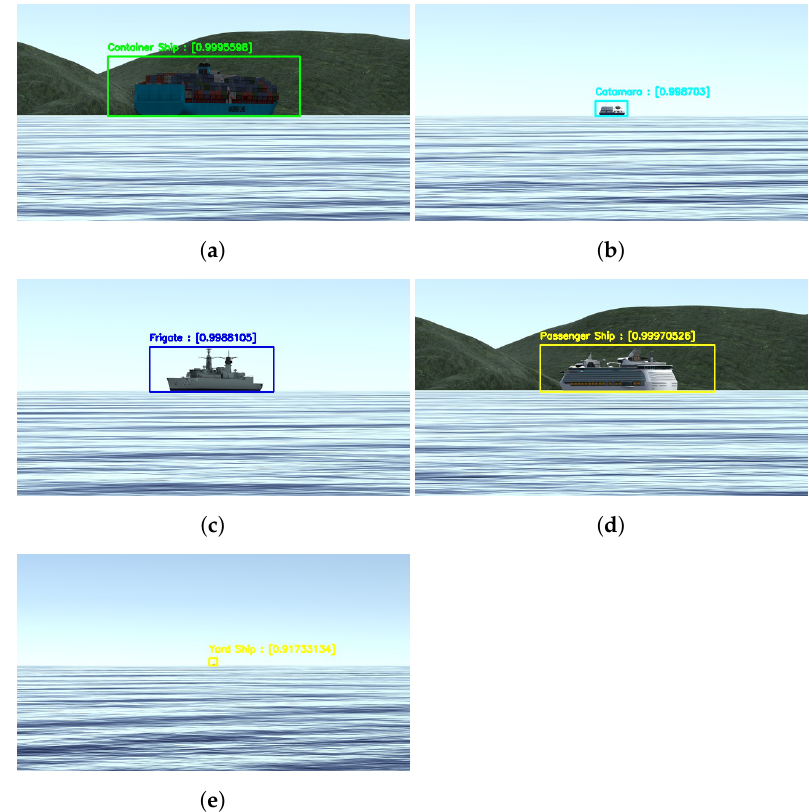
Figure 14. Some results from the detection and classification model applied on synthetic images. The distance is estimated in meters, and the bow angle is given in degrees. ( a ) Container Ship at 2000 m and 15 ◦ ; ( b ) Ferry at 4000 m and 160 ◦ ; ( c ) Frigate at 2000 m and 210 ◦ ; ( d ) Passenger Ship at 4000 m and 332 ◦ ; ( e ) Yard Ship at 4000 m and 332 ◦